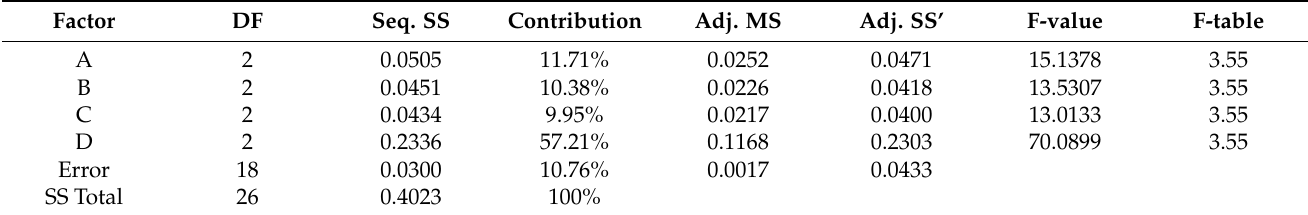
Table 11. ANOVA for grey relational grade.